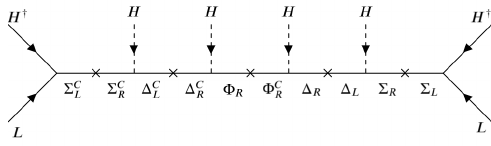
Figure 1 . Tree level diagram generating neutrino masses via low-energy effective operator of mass dimension-9. ‘ × ’ denotes mass insertion- either Majorana or Dirac